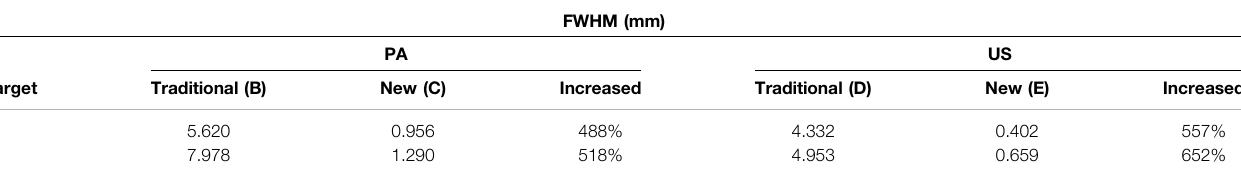
TABLE 2 | The FWHM values of target 1 and 2 in photoacoustic and ultrasonic results (Figures 5B – E) .